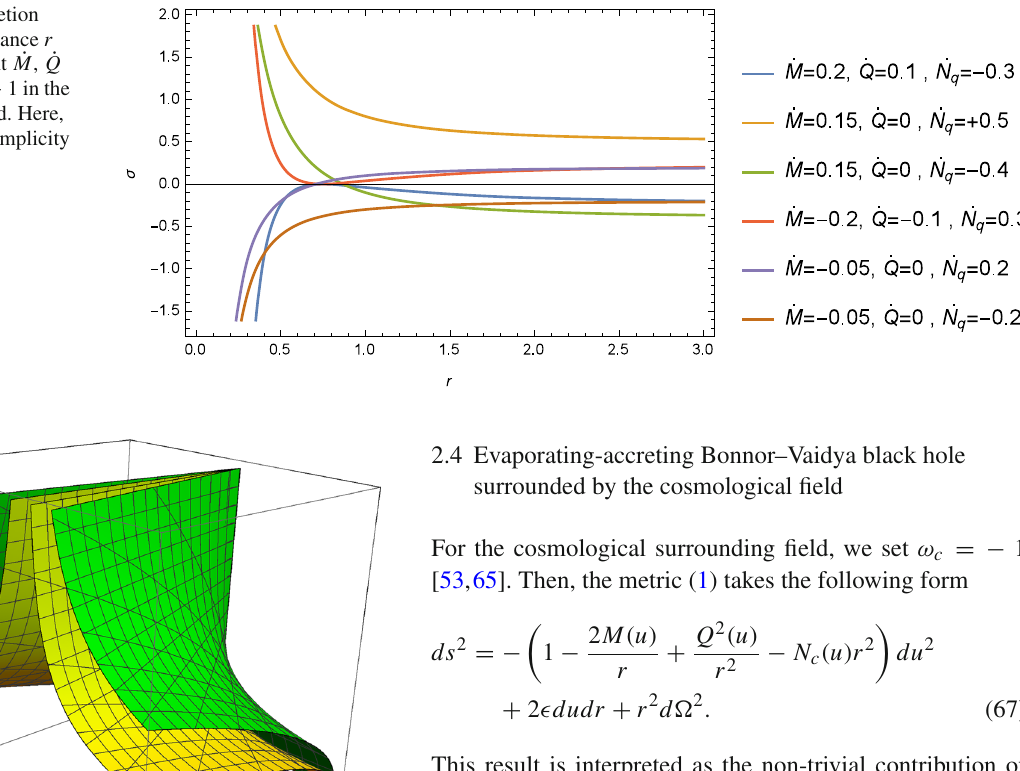
(green plot) and D s 1